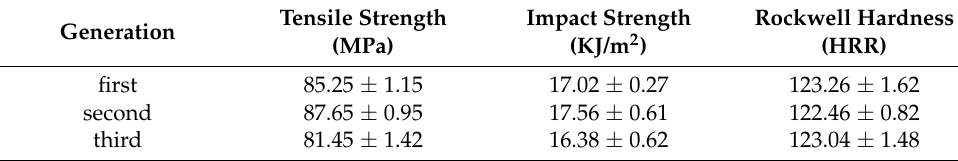
Figure 8. Circulation flow chart of MSiCw and MGO reinforced PI composites. Table 2. Mechanical Properties of MSiCw-1-MGO-0.3-PI composites after three generations.